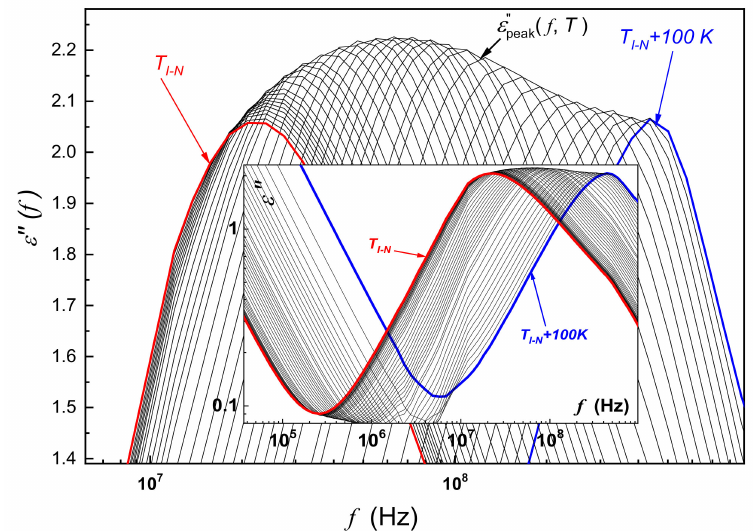
Figure A1. Changes of the imaginary part of dielectric permittivity in the isotropic liquid phase of 5CB. The inset shows experimental data in the log-log scale to visualize the Jonsher scaling (Equations (A1) and (A2)). The same data are presented in the semi-log scale in the central part of the figure, to show the temperature evolution of the height of the loss curve maximum, which follows Equation (A3). The primary ( alpha , structural ) relaxation time is determined from the primary loss curve frequency via the condition τ = 1/2 π f peak